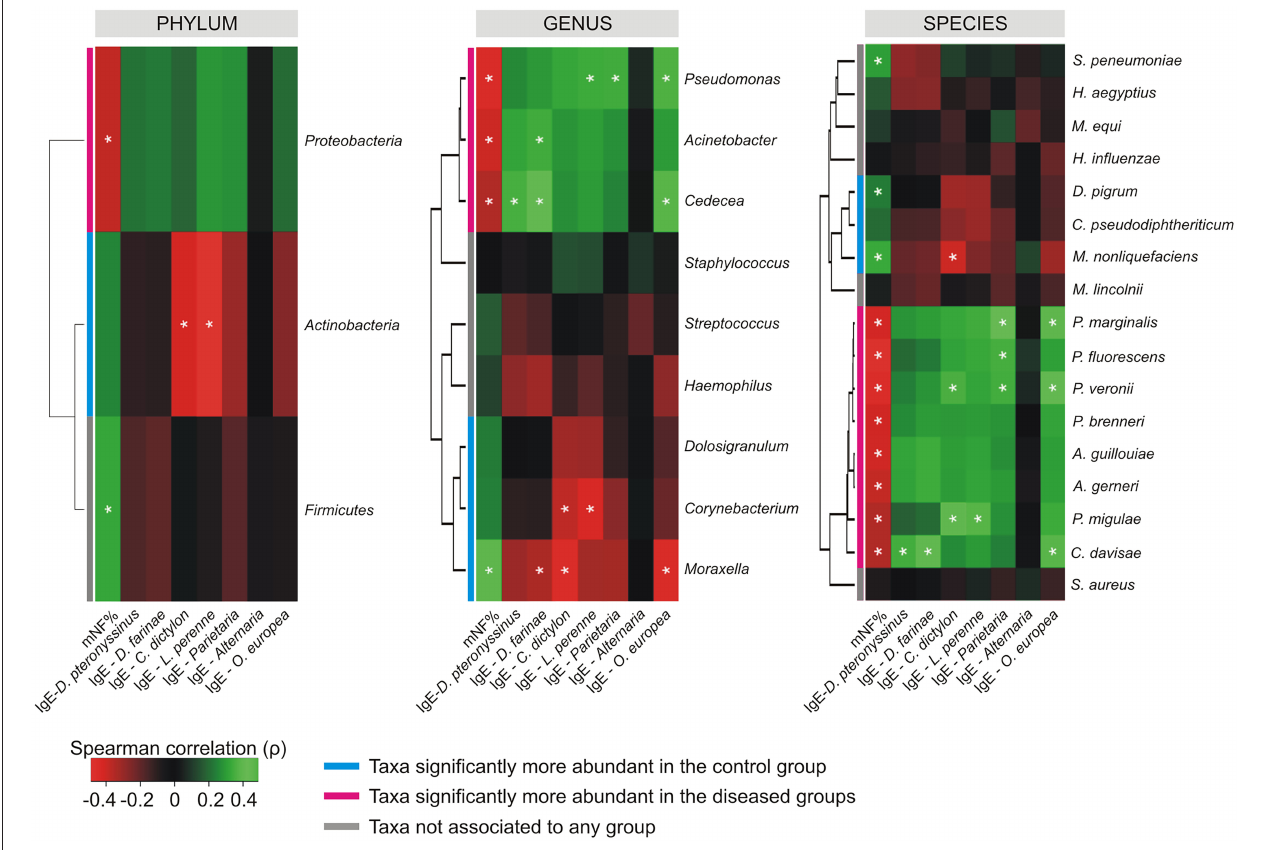
FIGURE 4 | Cross-correlation heatmaps based on Spearman’s correlation coefficients computed between the relative abundance of taxa ≥ 1% in at least one group and the values observed for mNF% and antigen-specific serum IgE across the whole population of studied subjects. The color scale represents values assumed by the Spearman’s correlation coefficient ( ρ ) with green and red for positive and negative correlations, respectively. Taxa were ordered according to hierarchical simple-linkage clustering based on Spearman’s coefficients computed on relative abundances (dendrogram on the left). The color coded bar indicates the differential association of taxa to groups according to results produced by the differential abundance analysis. A white asterisk indicates significant correlation at α level 0.05 after FDR correction for multiple comparisons.